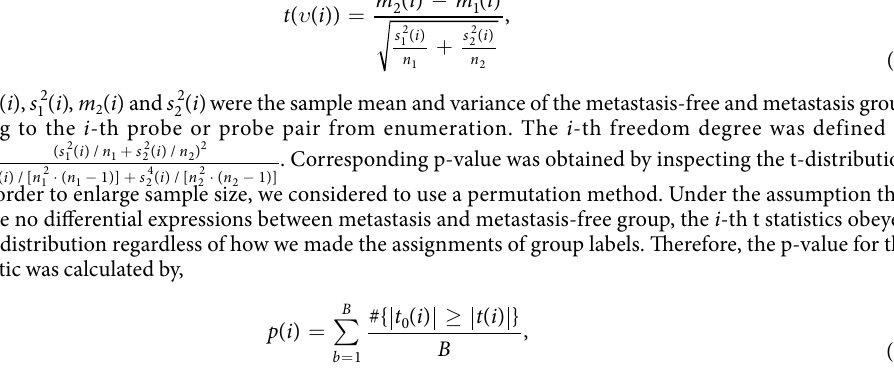
where m 1 ( i ), s i ( ) 12 , m 2 ( i ) and s i ( ) 22 were the sample mean and variance of the metastasis-free and metastasis group according to the i -th probe or probe pair from enumeration. The i -th freedom degree was defined as υ + − ⋅ table. In order to enlarge sample size, we considered to use a permutation method. Under the assumption that there were no differential expressions between metastasis and metastasis-free group, the i -th t statistics obeyed the same distribution regardless of how we made the assignments of group labels. Therefore, the p-value for the i -th statistic was calculated by, ∑ = where t 0 represented a null statistics by a random rearrangement of class label with B to be the times of permutation. IHT, voting and accumulation. In each round of re-sampling, IHT combined the error rate Er based on boundary perspective with p-value derived from model perspective. Considering different scales about the spatial distribution of scatters (p-value, Er ) representing individuals or pairs of probes, a voting strategy was made. In other words, individuals or pairs of probes were ranked by p-values and averages of Er s in an ascending order, respectively. Votes from the two aspects were accumulated together in order to select candidate individual miR- NAs or pairs. In detail, the voting strategy was proposed as Table 6.